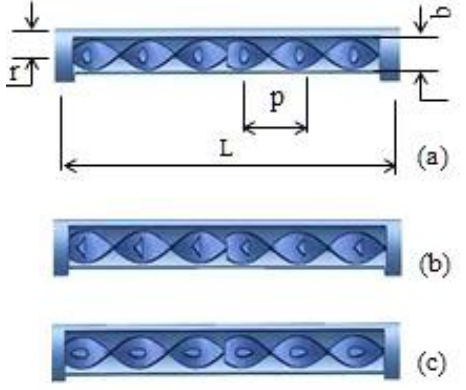
Figure 1. Induced tubes’ geometries: (a) C-C tube, (b) C-T tube, (c) C-E